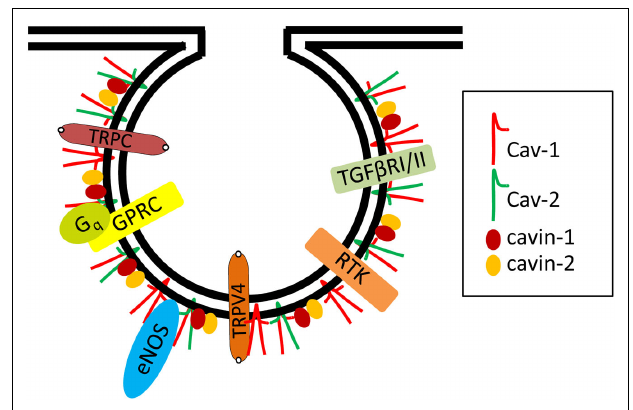
FIGURE 1 | Examples of signaling proteins localized in endothelial cell caveolae. Several signaling molecules were localized in endothelial caveolae and interact with Cav-1 including eNOS, RTK (e.g.,VEGF Receptor 2), GPRC (e.g., Bradykinin Receptor 2, Endothelin Receptor, Muscarinic Receptor), heterotrimeric G protein subunits (e.g., Gq),TGF-beta Receptors I and II, calcium channels (e.g.,TRPC1 and 4,TRPV4).